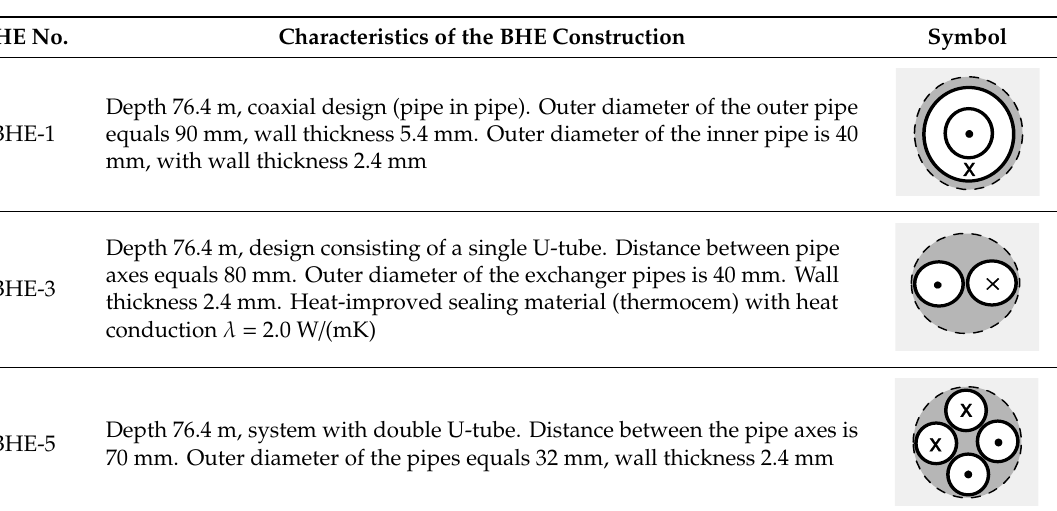
Depth 76.4 m, system with double U-tube. Distance between the pipe axes is BHE-5